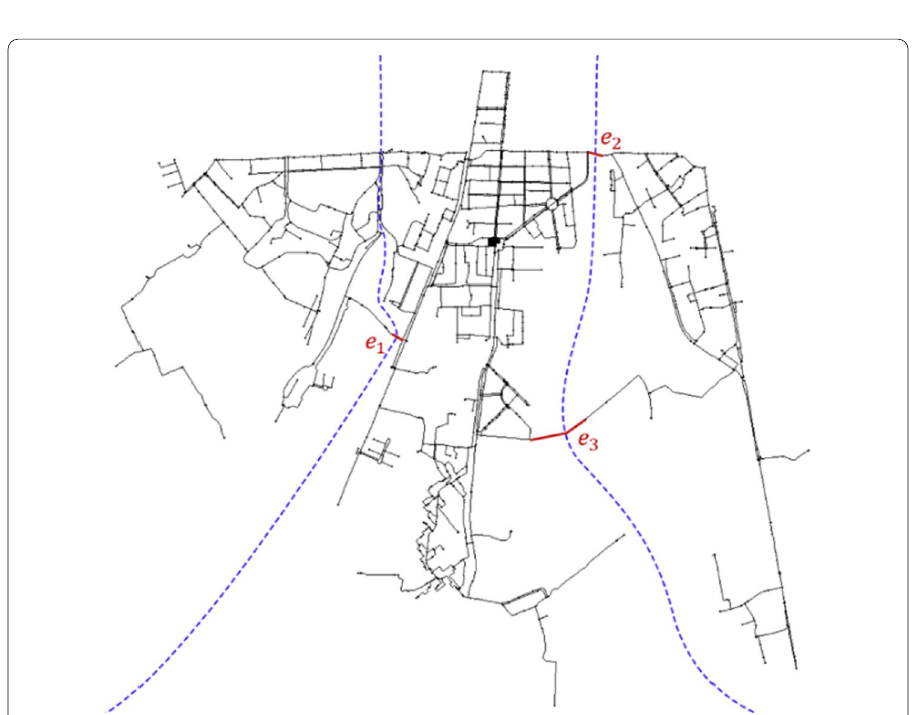
Fig. 5 Abbiategrasso WDN (clustering with K